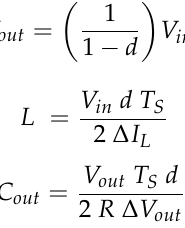
Figure 20. Simulation diagram (PV group) of a PV system with a boost converter. Table 2. PV panel specifications and parameters of the simulated system with boost converters.